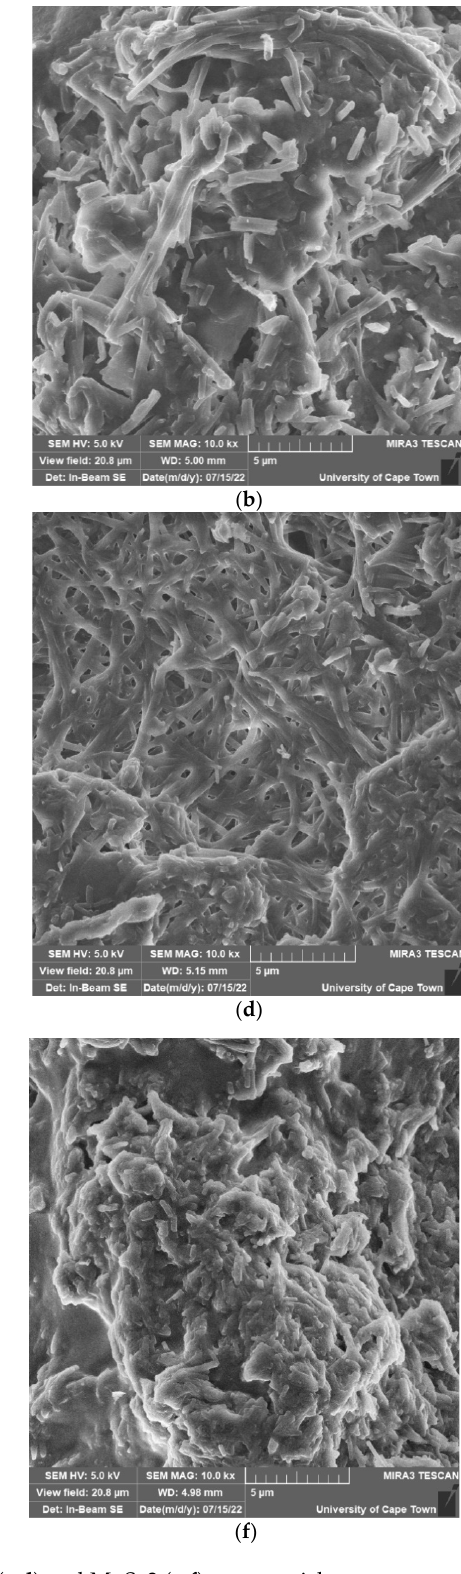
Figure 7. FESEM images of MnS_1 ( a , b ), MnS_2 ( c , d ) and MnS_3 ( e , f ) nanoparticles.